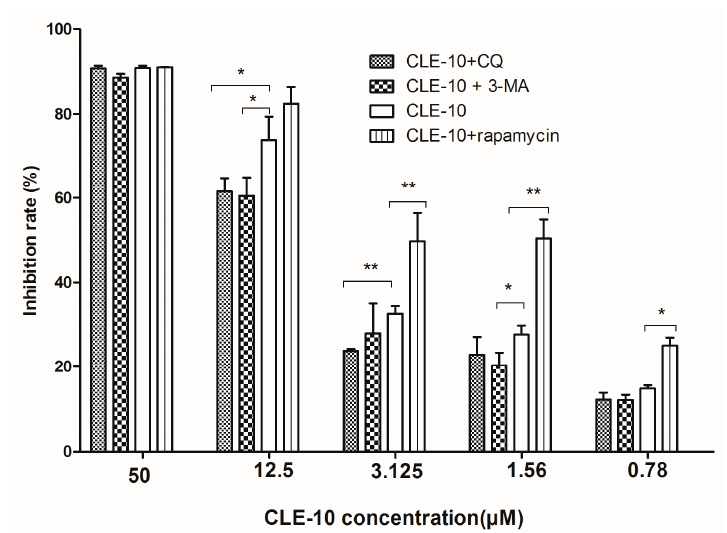
Figure 3. The inhibitory effect of CLE-10 pretreated with or without autophagy inhibitors (5 mM 3- methyladenine (3-MA), 20 µM chloroquine (CQ)) or inducer (100 nM rapamycin) on the proliferation and growth of MDA-MB-232 cells for 48 h. (* p < 0.05, ** p < 0.01, *** p < 0.001 compared with the CLE- 10 group).